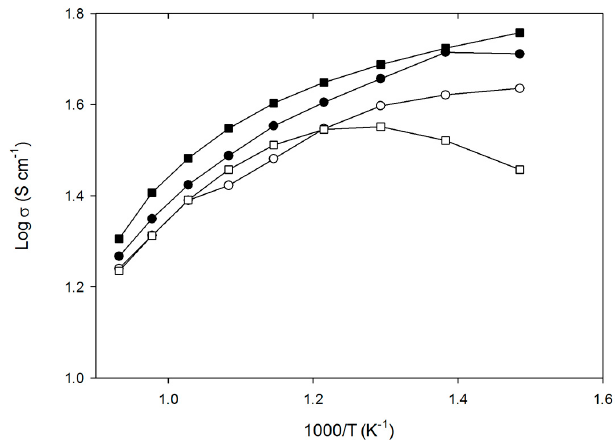
Figure 9. Plot of log σ vs. 1000/T for SrFeO 3- δ ( ● ), SrFe 0.975 S 0.025 O 3- δ ( ○ ), SrFe 0.95 S 0.05 O 3- δ ( ■ ) and SrFe 0.925 S 0.075 O 3- δ ( □ ) in air.